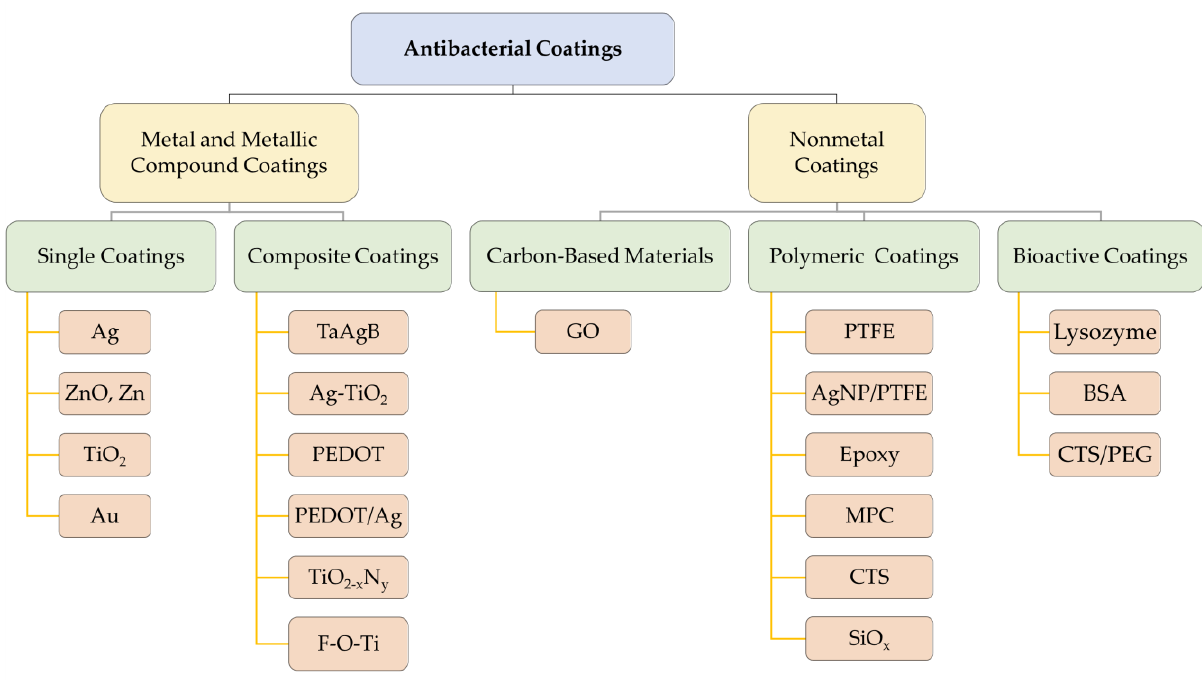
Figure 5. Summary of antibacterial coating materials. Au: gold; Ag-TiO 2 : silver-titanium dioxide; PEDOT: poly(3,4-ethylenedioxythiophene); PEDOT/Ag: poly(3,4-ethylenedioxythiophene)/silver; TiO 2−x N y : nitrogen-doped titanium dioxide; F-O-Ti: fluorine and oxygen double-deposited titanium; AgNP/PTFE: nanosilver/polytetrafluoroethylene; SiO x : silicon oxides; BSA: bovine serum albumin; CTS/PEG: chitosan/polyethylene glycol.